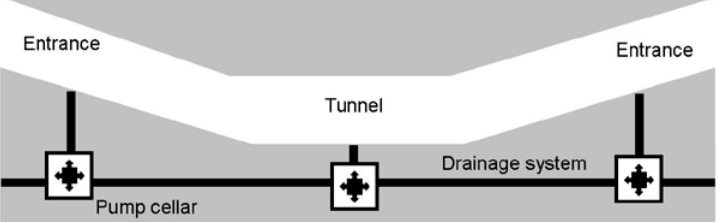
Figure 2. Schematised (not to scale) representation of the tunnel (in longitudinal direction) used as test case. Dimensions can be found in Huibregtse et